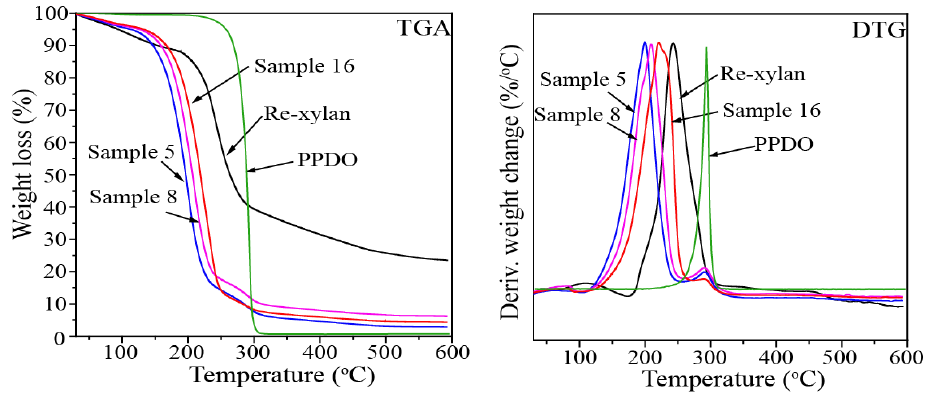
Figure 4. TGA and DTG curves of regenerated xylan, pure PPDO, and xylan- g -PPDO copolymer samples 5 (WPG = 431.07%), 8 (WPG = 316.72%), and 16 (WPG =